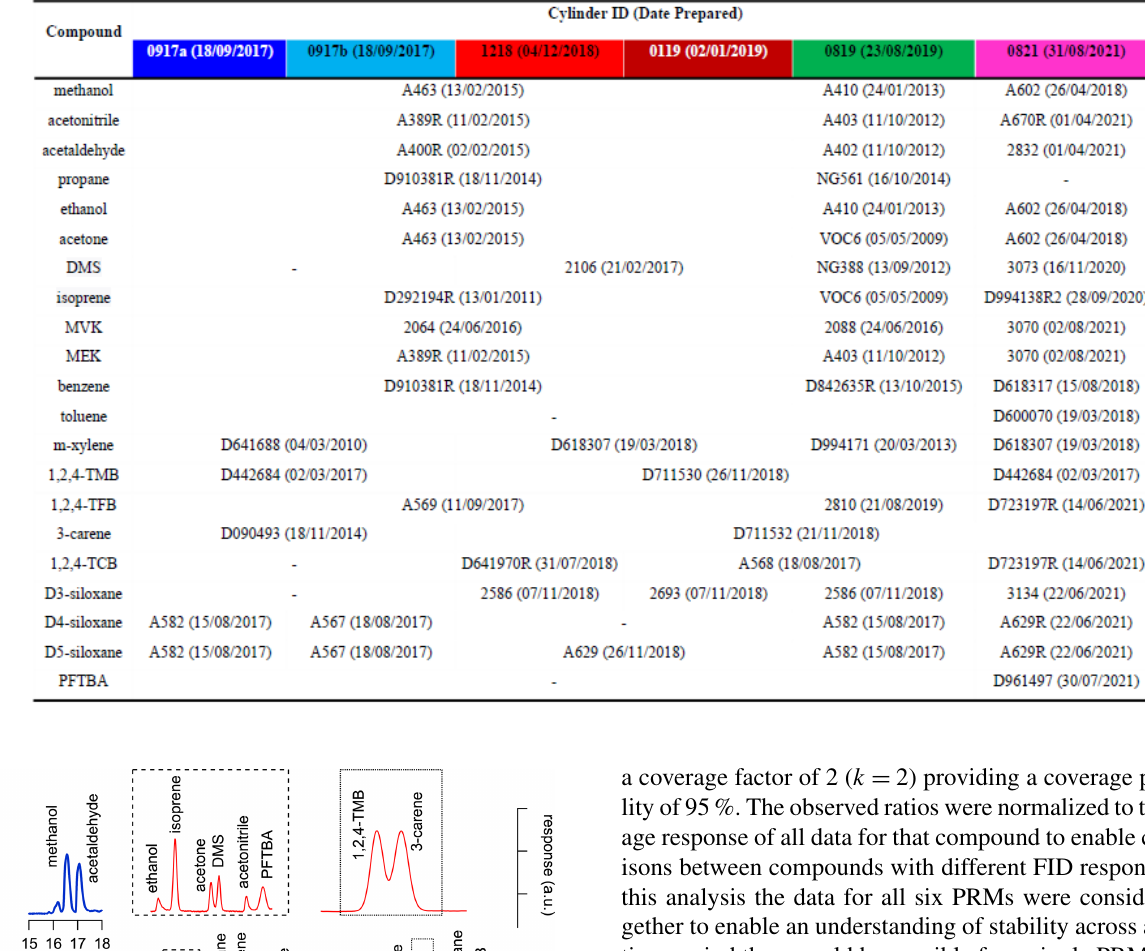
Table 2. Composition, hierarchies and parent cylinder IDs (dates prepared) for all components for the six PRMs (0917a, 0917b, 1218, 0119, 0819, and 0821) prepared in this work. The PRMs are identified by the date and year of their preparation (MMYY). As the first two were produced at the same time, the suffixes a and b were added to distinguish them. The colour scheme in the table headers is matched to that used in the figures throughout the paper.